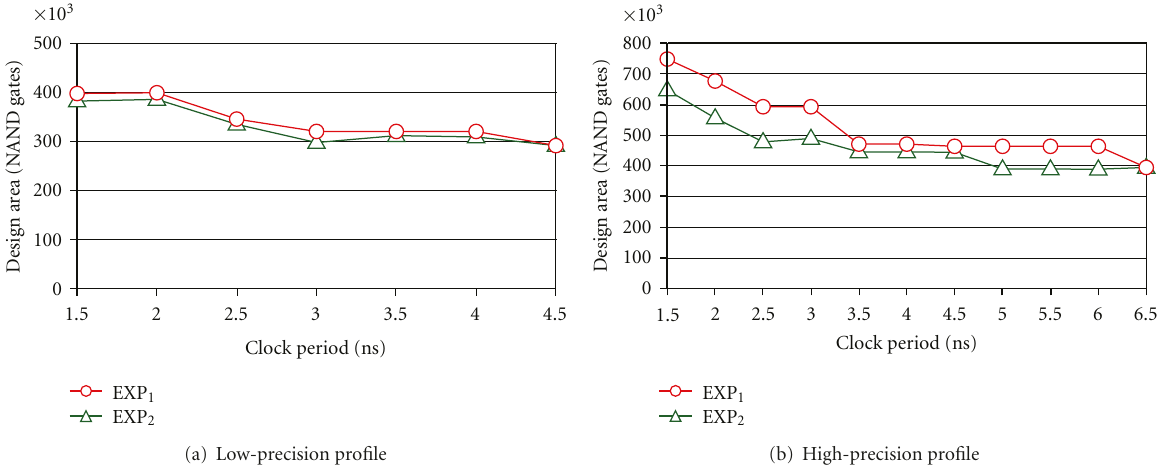
Figure 12: Area when the synthesis is constrained by a 240-clock cycle latency constraint—65 nm ASIC technology.